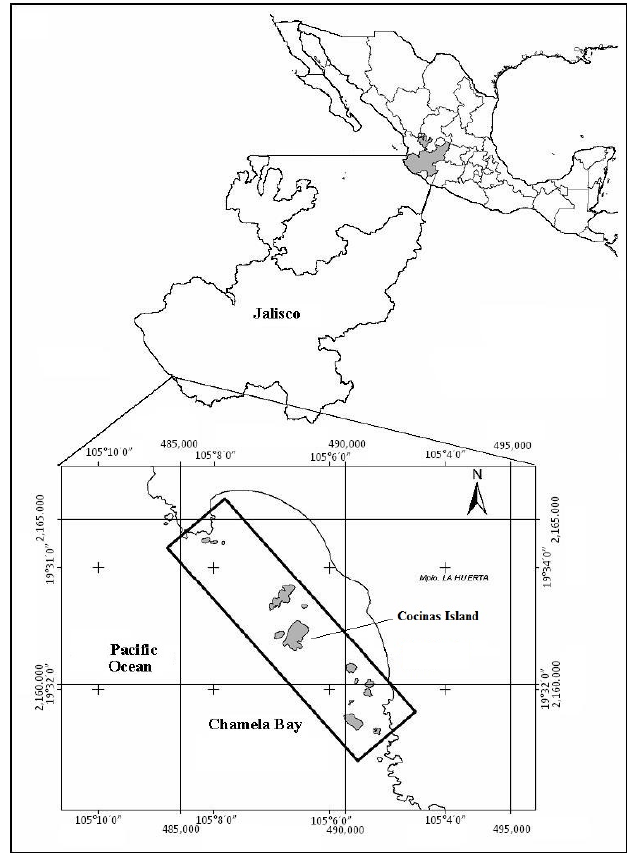
Map of Jalisco, México showing the location of Cocinas Island within Chamela